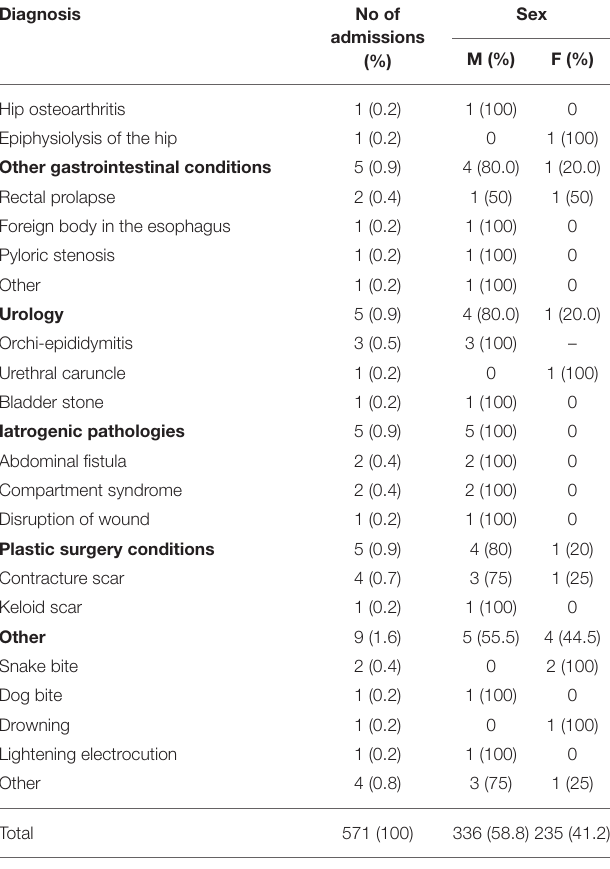
TABLE 1 | Diagnoses made for the children admitted to Mutoyi Hospital in the Surgery Ward in